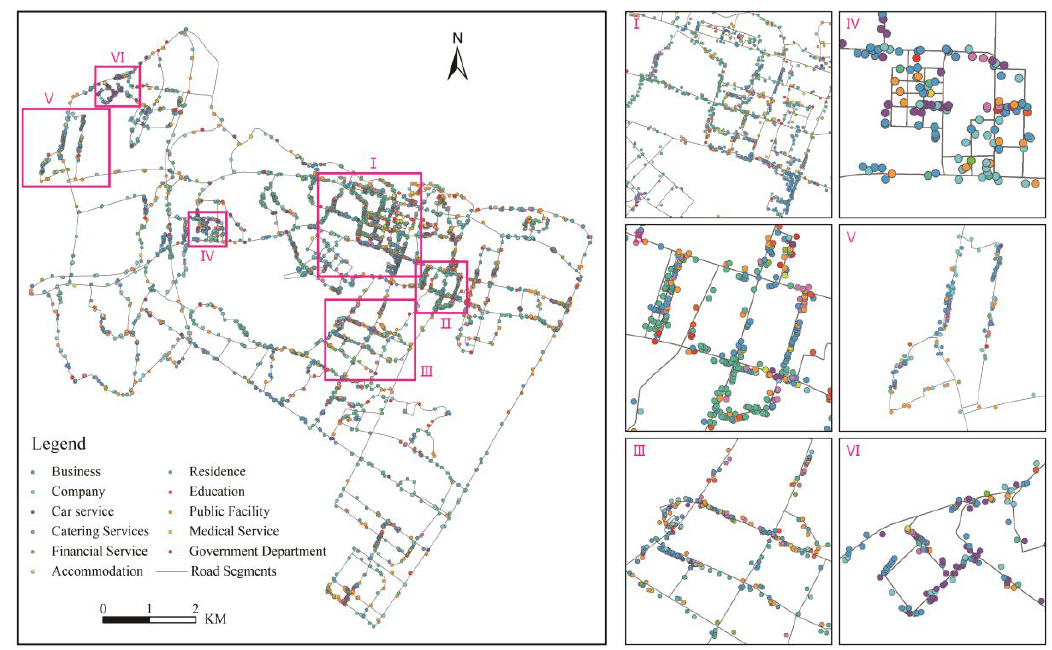
Figure 7. Points of interest (POIs) of Hanyang district included six aggregated regions: I, Wangjiawan; II, Wuhan Technician College; III, Longyang Village; IV, Huangjinkou Urban Industrial Park and Wantong Industrial Park; V, Shengyuan Yuanhua Industrial Park; and VI, Huangjinkou Auto Parts